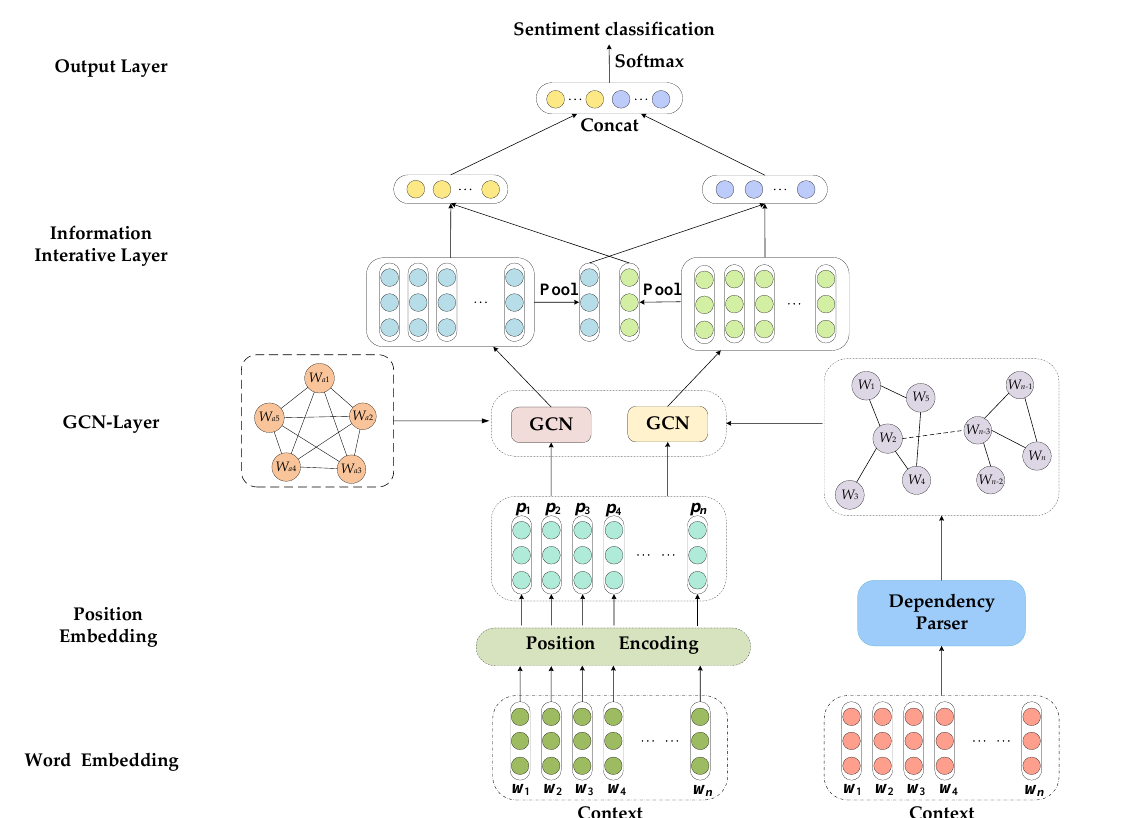
Figure 3. The overall framework of the proposed DC-GCN model.